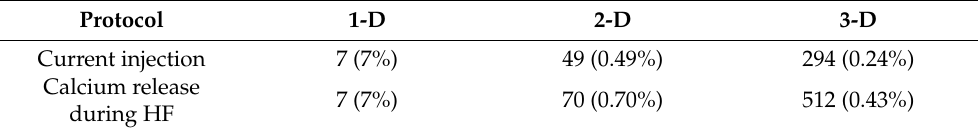
Table 2. The number of myocytes needed to trigger propagation of action potential.